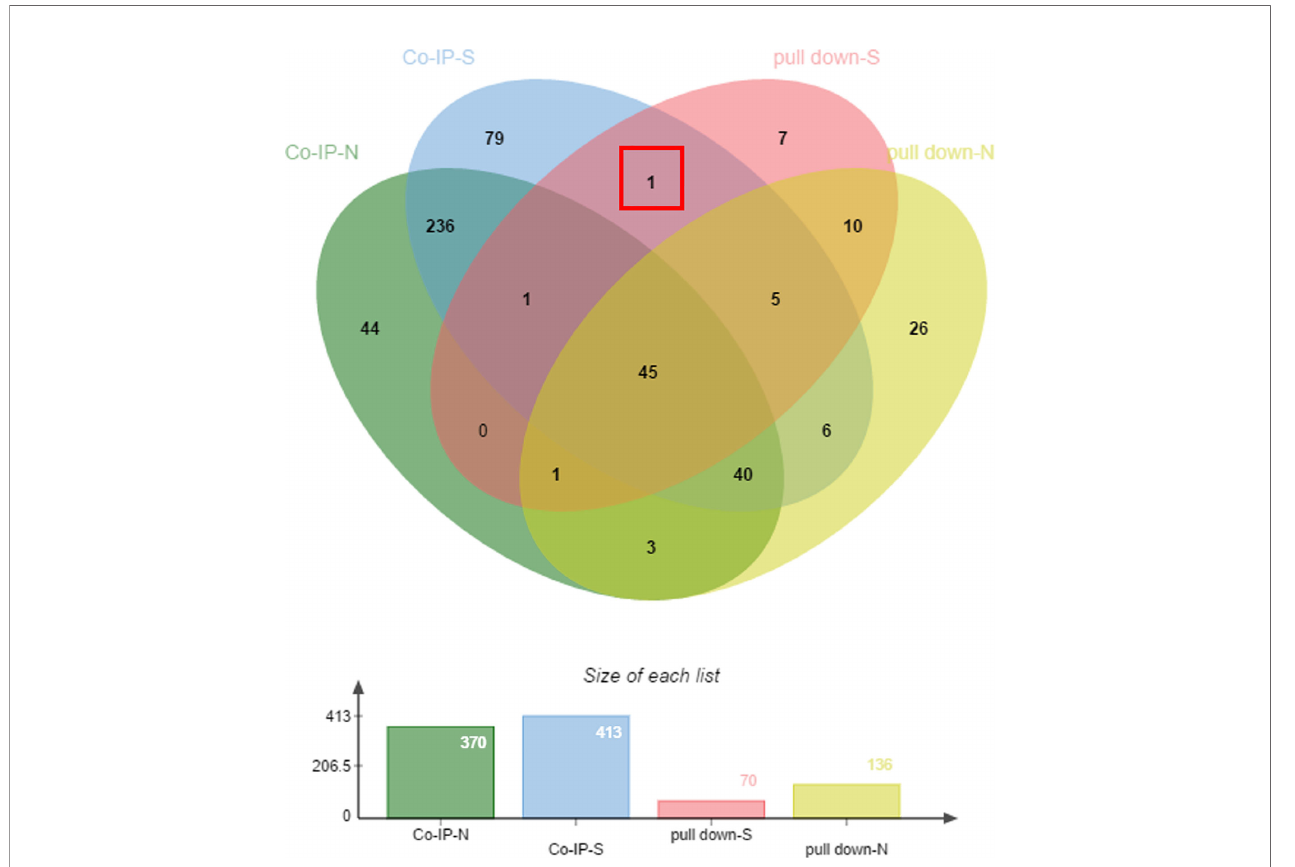
FIGURE 1 | Mass spectrometry analysis of co-immunoprecipitated and pulled-down fractions. pull-down-S, positive control of pull down; pull-down-N, negative control of pull down; co-IP-S, positive control of co-IP; co-IP-N, negative control of